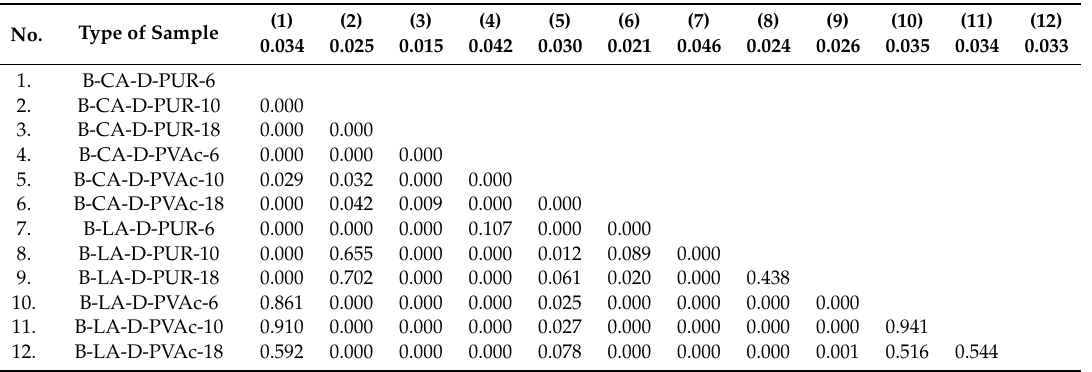
Table 21. Comparison of the e ff ects of individual factors using Duncan’s test on the coe ffi cient of bendability ( K bendC ) for beech and NWC on the bottom.